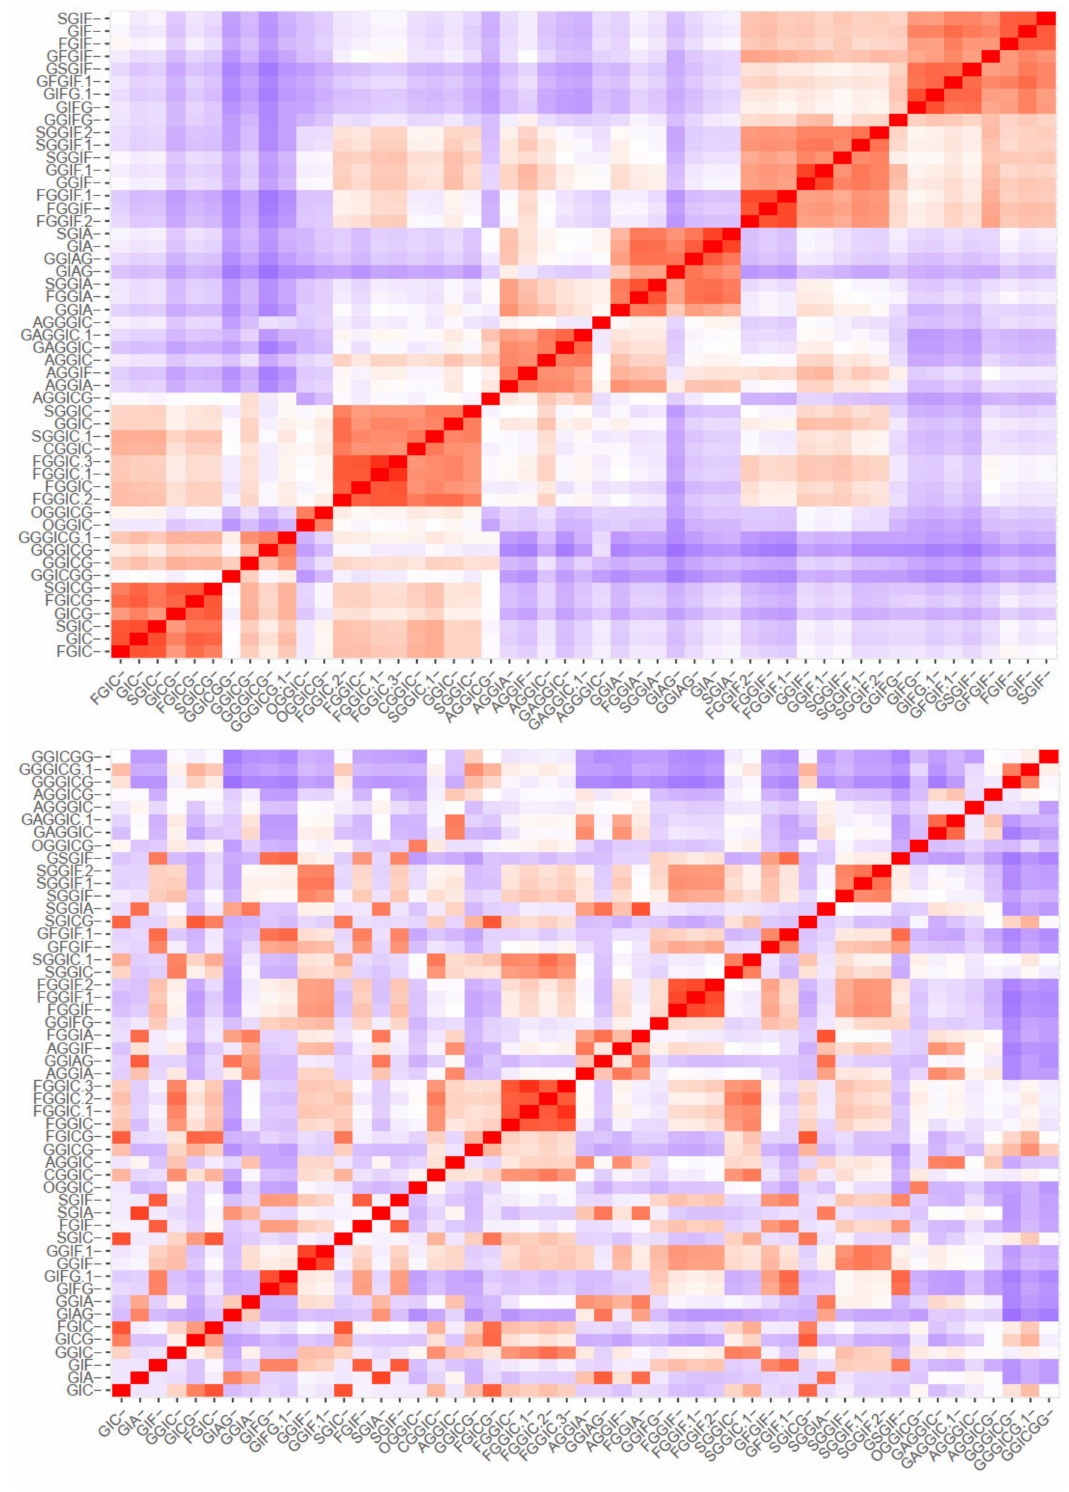
Figure 5. Ordered and unordered heatmaps based on a distance matrix using the MS 2 data of the 51 identified oleracein (red—higher and blue—lower